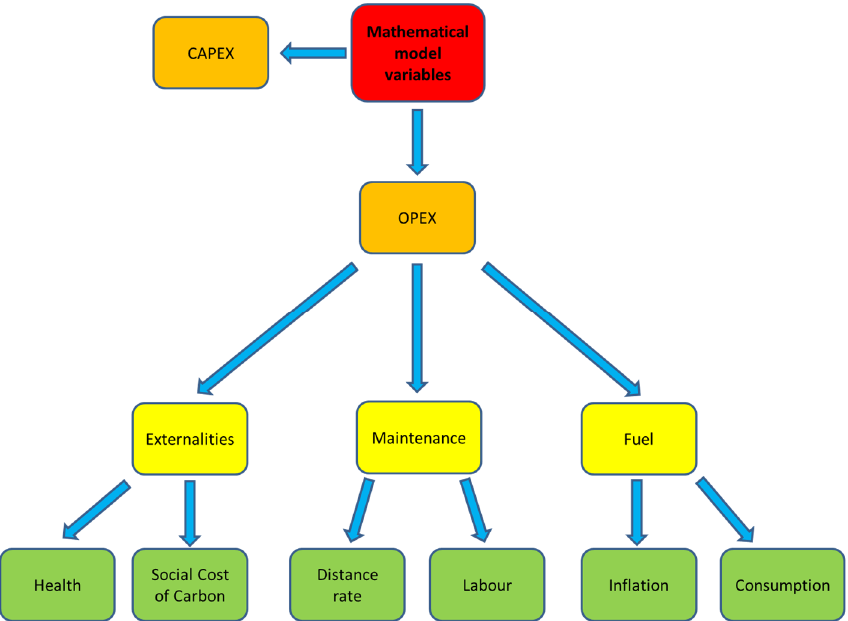
Figure 1. Common variables considered for the mathematical model and their relations.